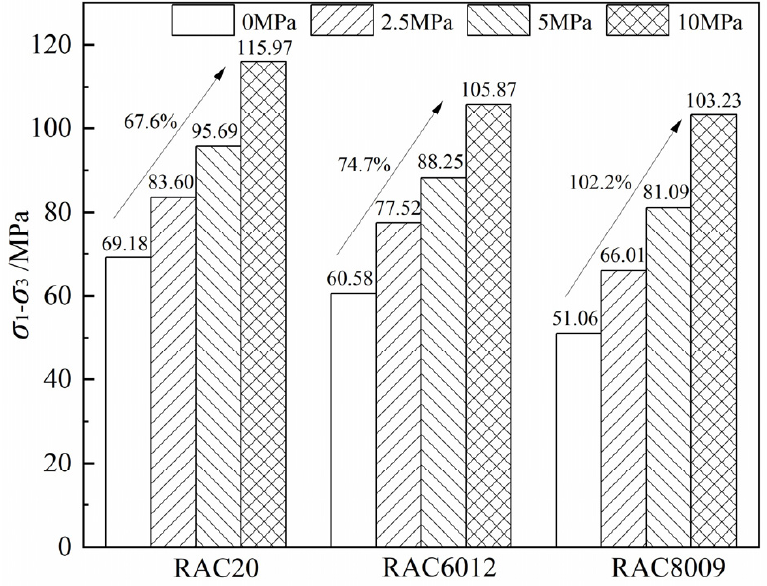
Figure 7. Effect of confining pressure on peak deviatoric stress.